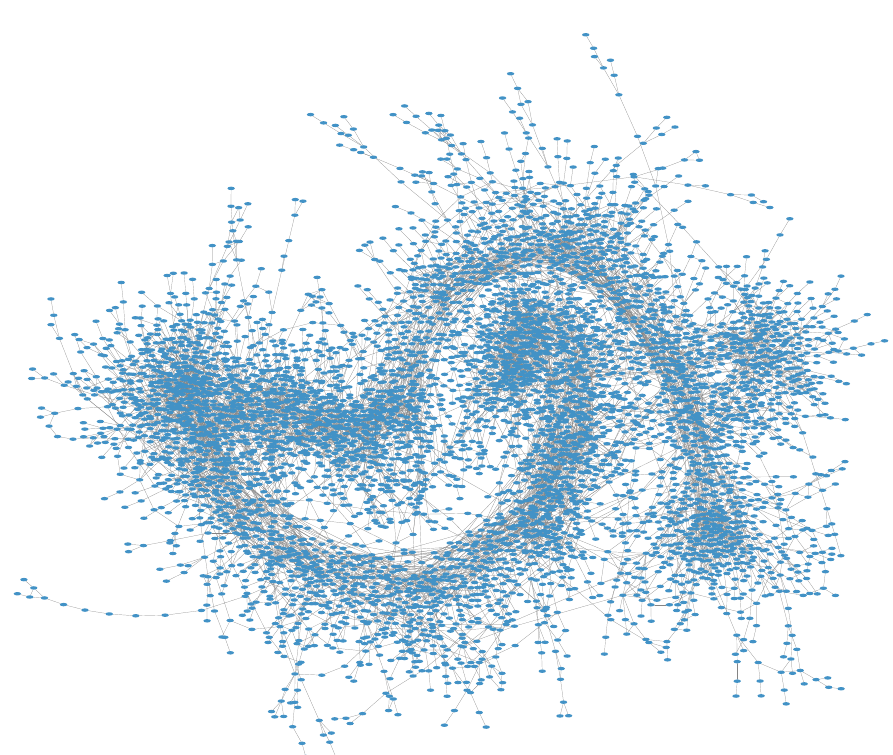
Figure A1. Graphical representation of the giant connected component of the network of interactions, for executed trajectories of 1 September 2018. Links represent instances in which the corresponding pair of aircraft interacted, i.e., their horizontal separation was less than ρ = 10 NM and the vertical distance less than 2000 feet. Picture created in Cytoscape 3.8 with yFiles Organic Layout embedding, © Cytoscape